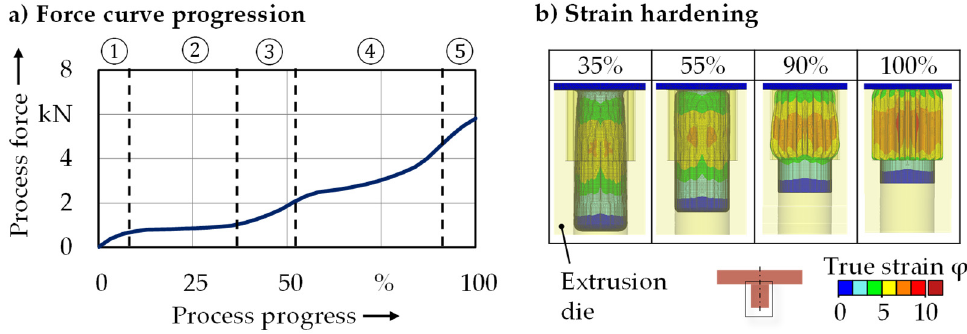
Figure 8. ( a ) Force curve progression and ( b ) strain hardening during lateral extrusion.